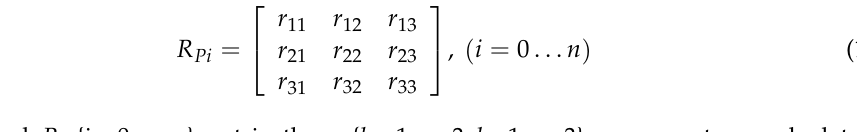
Figure 2. Kinematic analysis of hyper ‐ redundant robots [43].